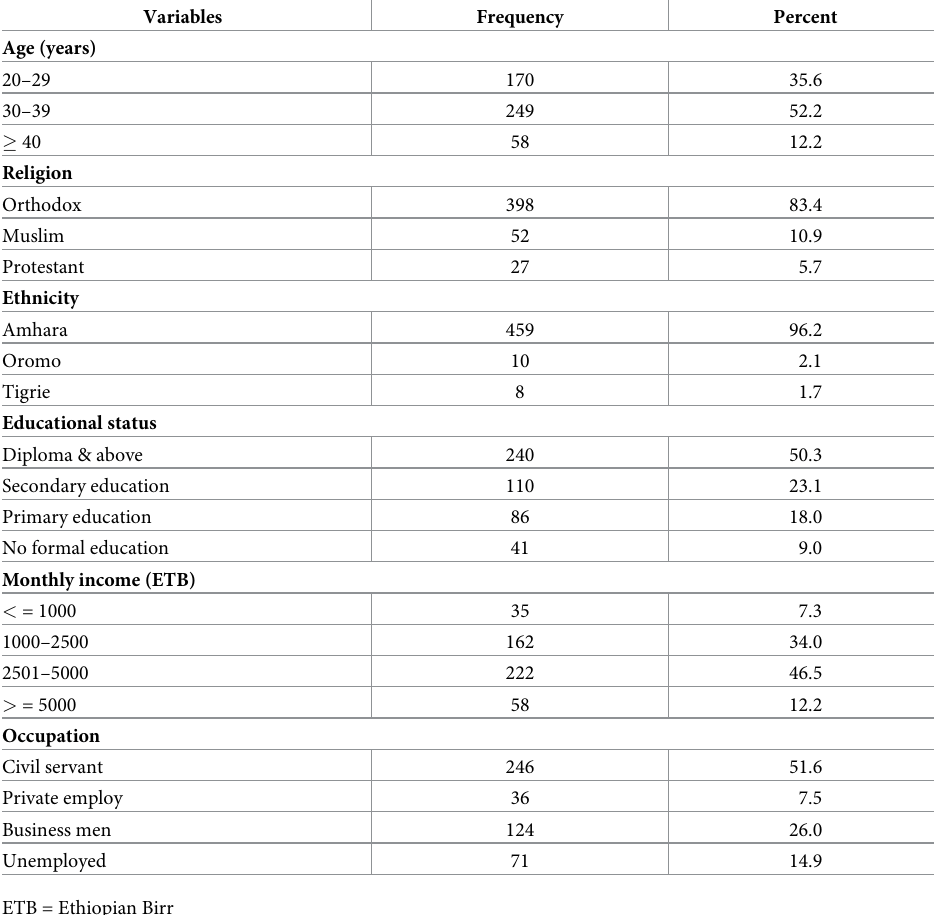
Table 2. Socio-demographic characteristics of study participants in Debre Tabor town, North-West Ethiopia, 2019 (n = 477). Variables